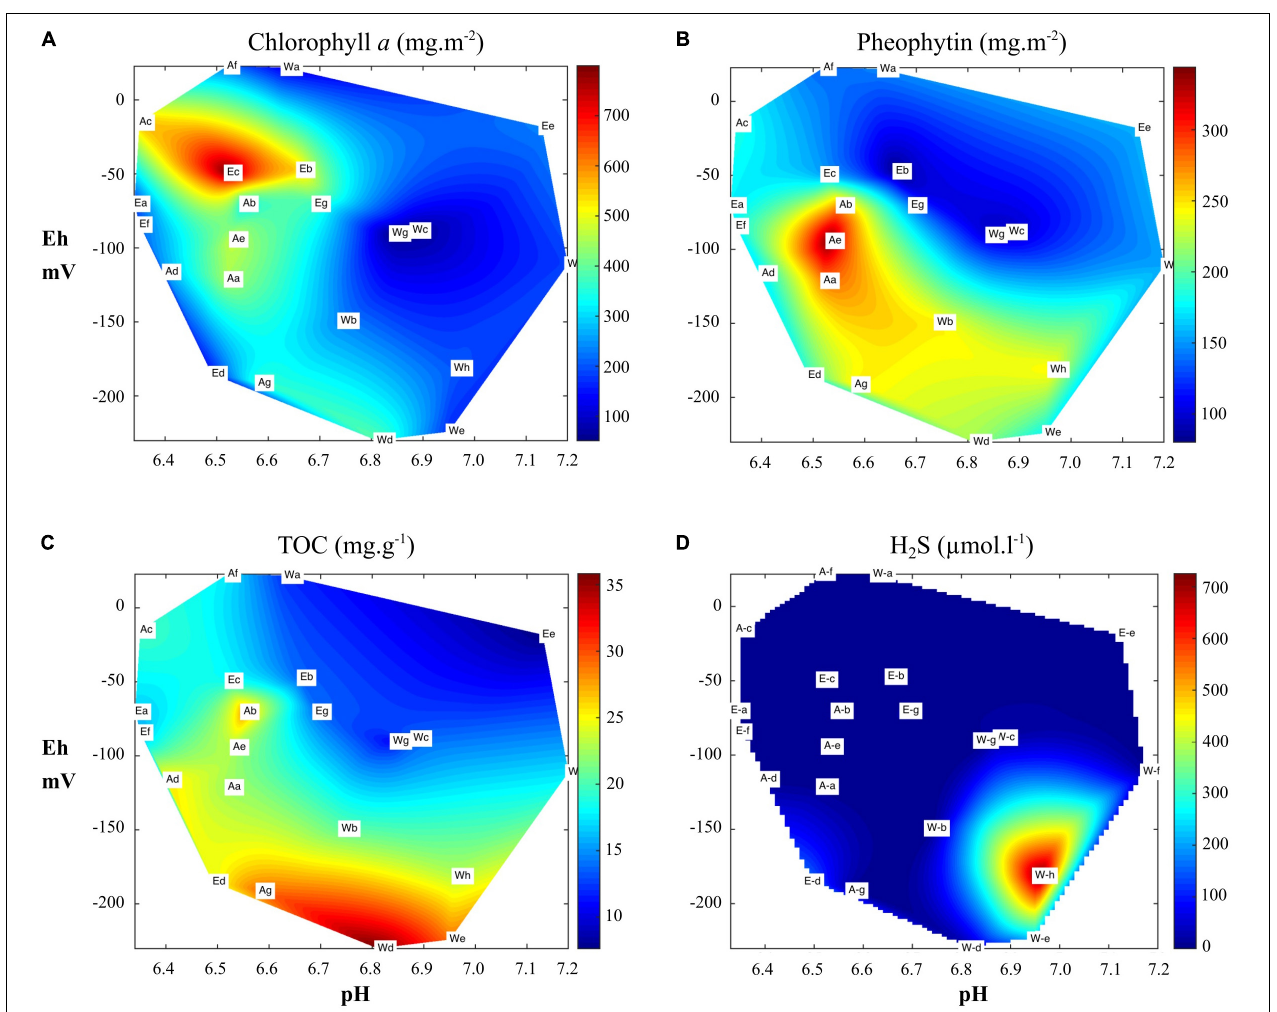
FIGURE 3 | Redox distribution of (A) chlorophyll a , (B) pheophytin, (C) total organic carbon (TOC), and (D) H 2 S in pore water in relation to the pH as observed in the three ponds in the first cm of sediment.